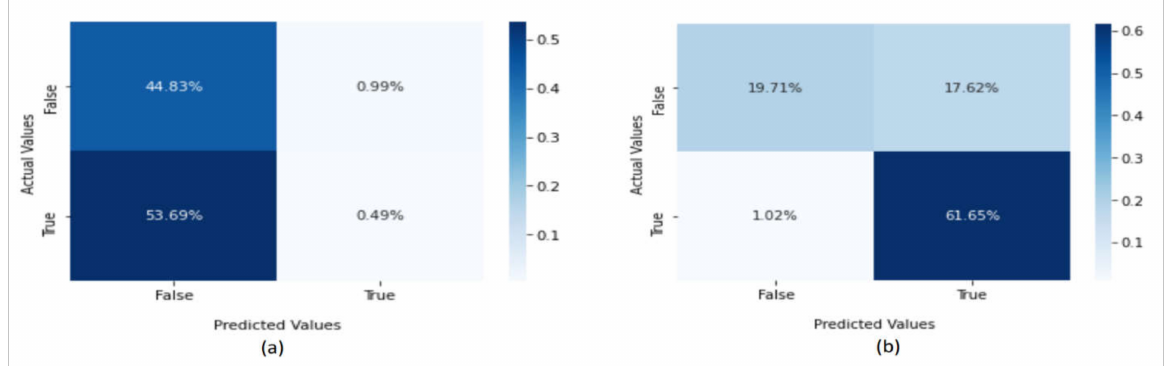
Figure 12. The confusion metrics for the ( a ) CICAndMal2017 and ( b ) Drebin datasets.